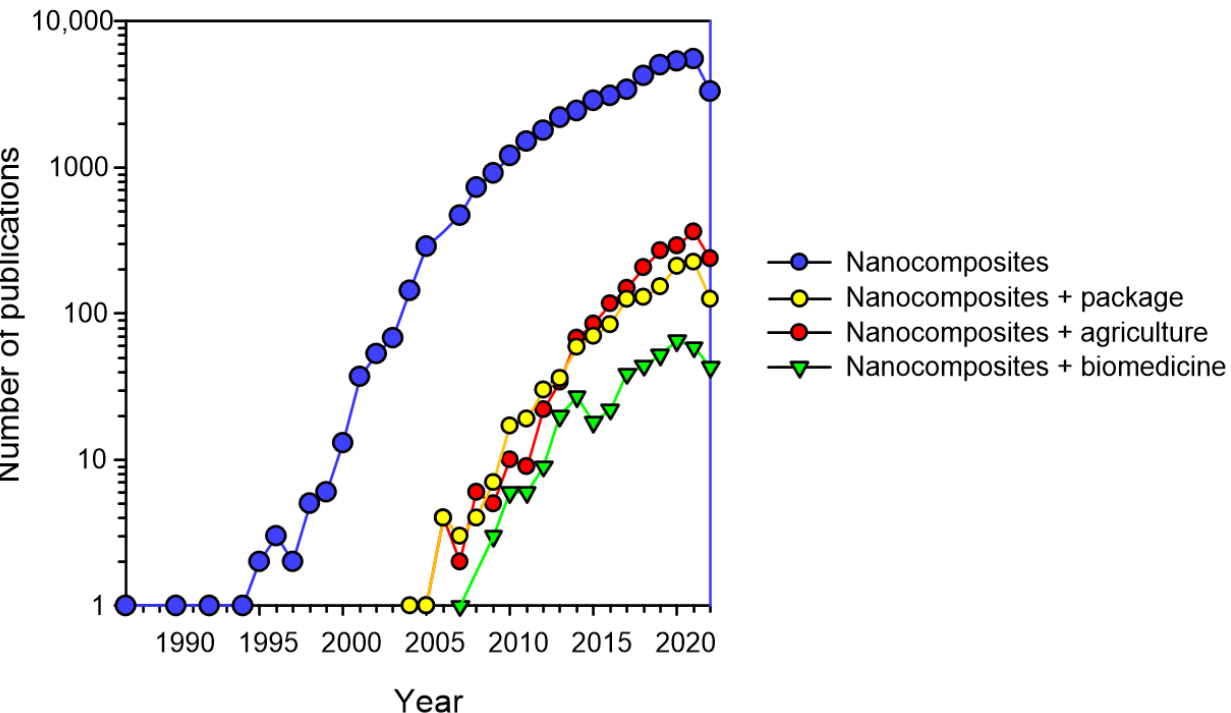
Figure 1. Number of publications devoted to nanocomposites (data 1 July 2022 https://pubmed.ncbi.nlm.nih.gov/).